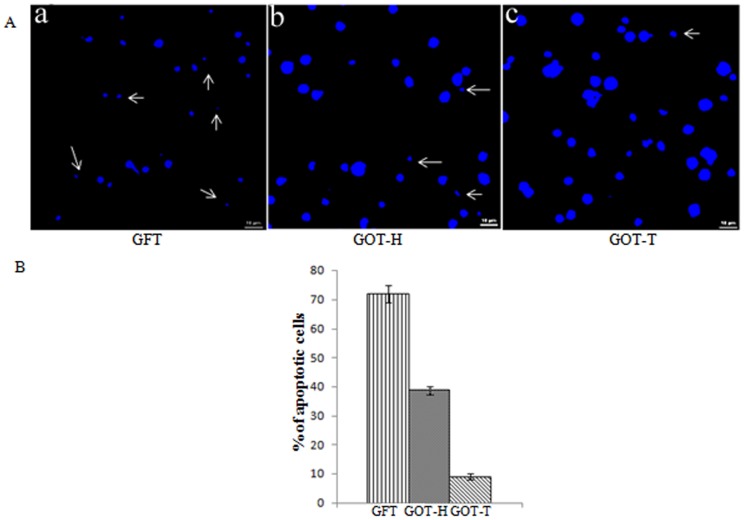
Hoechest staining of granulosa cells.Confocal images (Fig. 7A) of isolated granulosa cells from GFT ovaries (Fig.7A-a) appear shrunken and irregularly shaped with fragmented nuclei (←), while the those isolated from GOT-H (Fig.7A-b) and GOT-T (Fig.7A-c) ovaries exhibit regular contour with round and large nuclei indicating healthy cellular condition. Each image is one representative of 9 replicates, 3 replicates from each pool of cells and each pool represents 6-8 rats of the respective groups. The histogram (Fig. 7B) shows the mean percentage ±SEM of apoptotic cells counted in 9 microscopic fields at ×100. There are 3 randomly selected fields per slide, and each slide is represented by granulosa cells from 6-8 rats of the respective group. GFT vs. GOT-H: P<0.0001; GFT vs. GOT-T: P<0.0001.